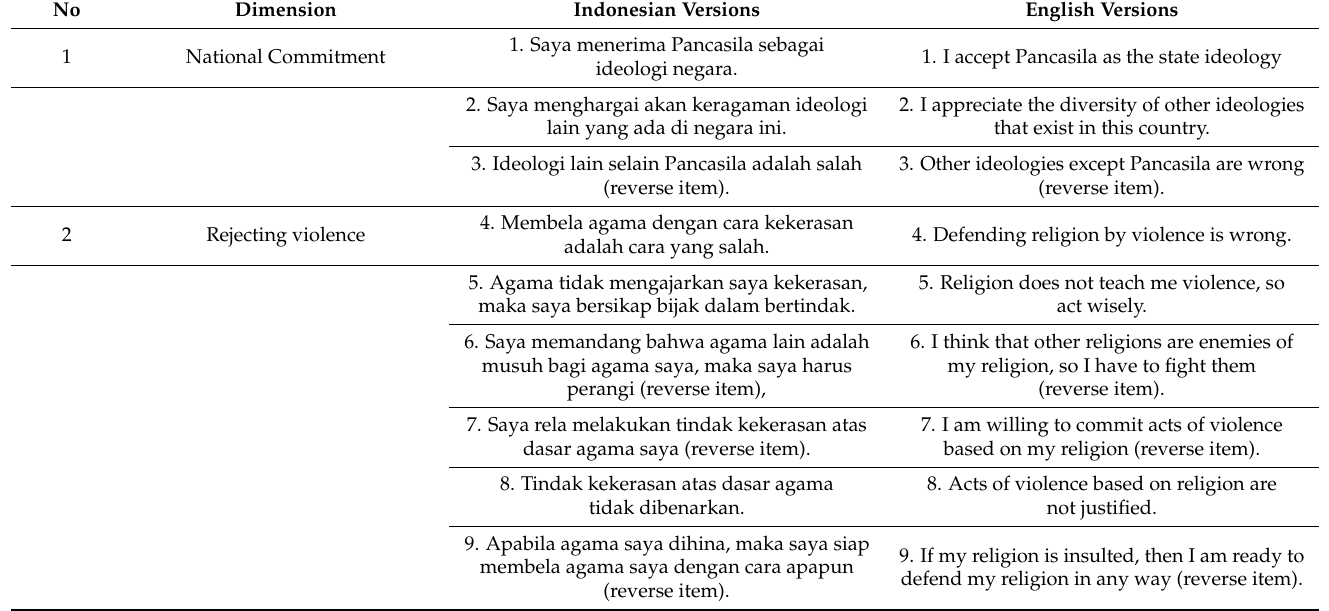
Table A2. Religious moderation